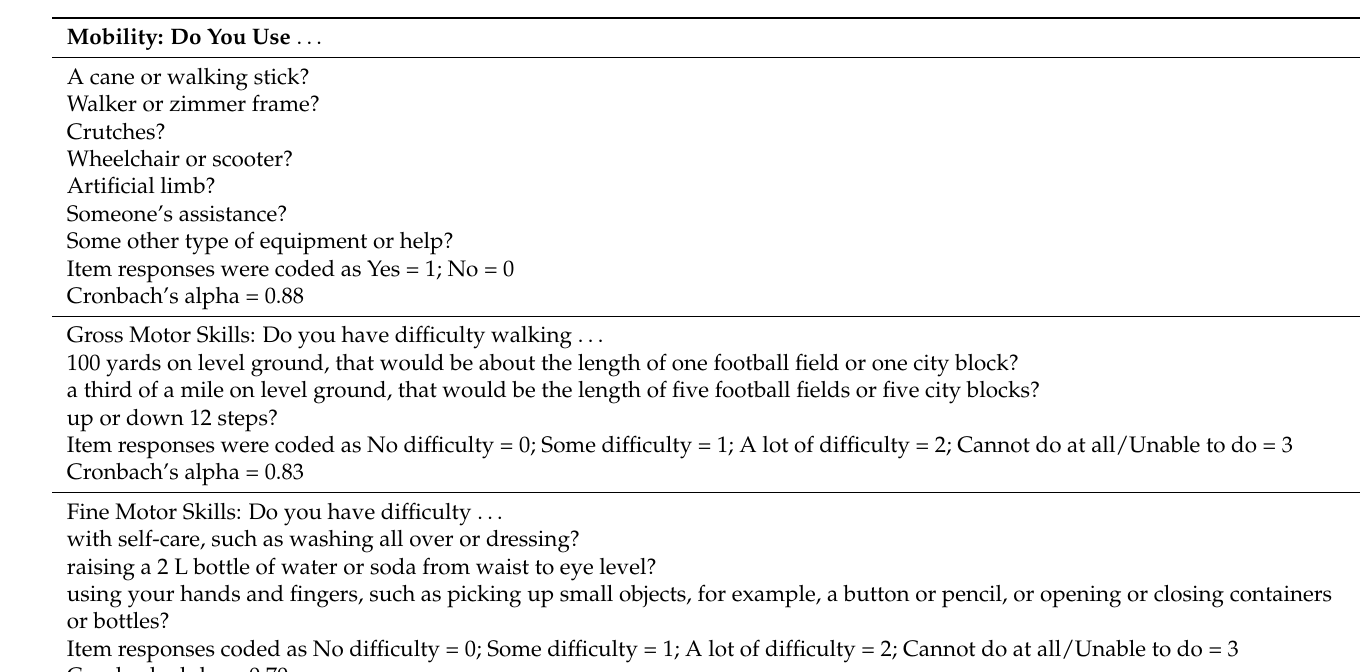
Table 1. Functional Limitation